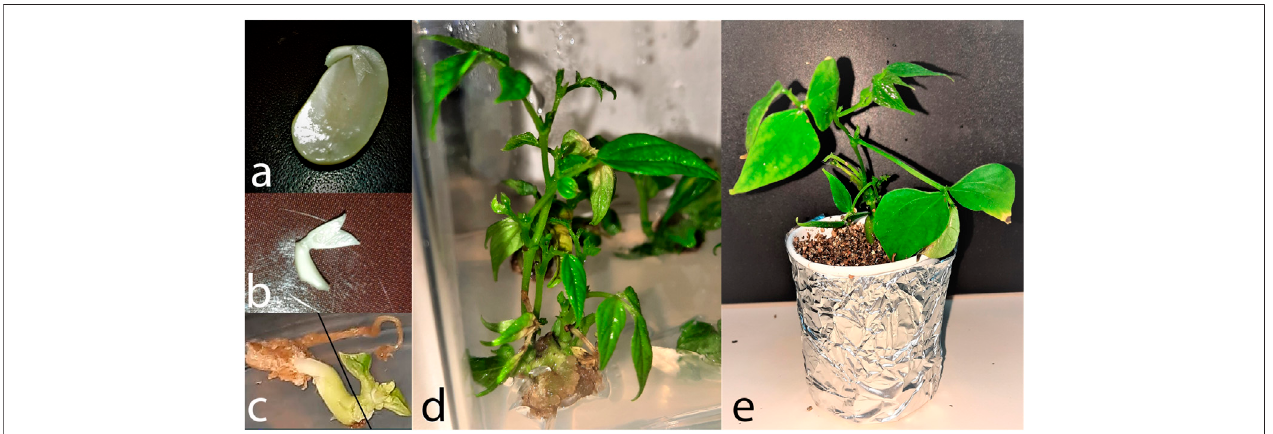
FIGURE 1 | In vitro regeneration and rooting of common bean Cv. Karaca ş ehir 90 (A) sterilized seed with the intact embryo, (B) isolated embryo ready for inoculatingonthepretreatmentmedium, (C) pretreatedmatureembryousedforisolatingtheplumularapiceexplant, (D) multipleshootinductionfromtheplumularapice explant, and (E) acclimatized plant in a pot containing